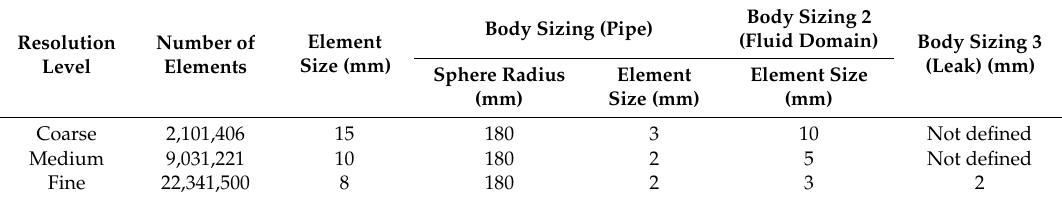
Table 4. Size settings for the 3 considered mesh resolutions.